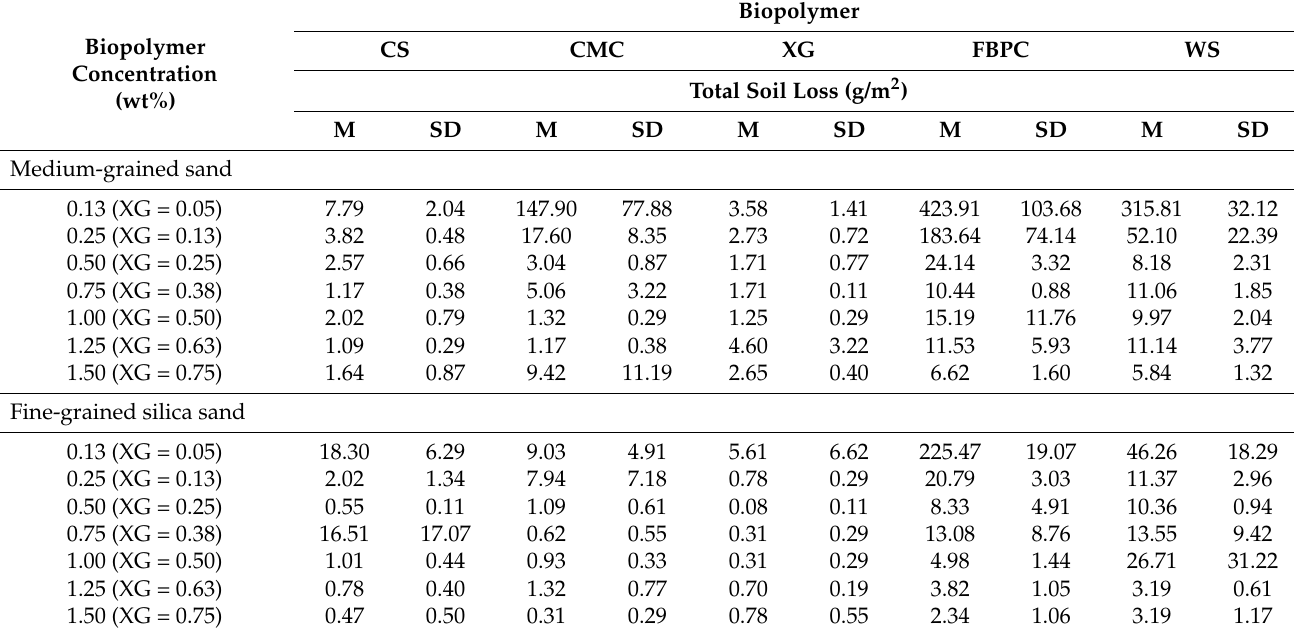
Table A1. Results of Phase 1 wind tunnel tests. Total wind-induced soil loss after the fifth wind